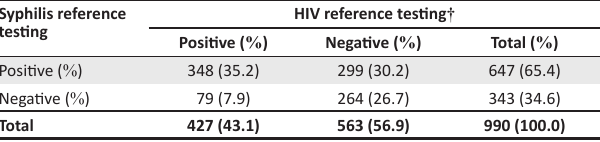
TABLE 1: Composition of the evaluation panel characterised for HIV and syphilis in 2013 ( N = 990). Syphilis reference